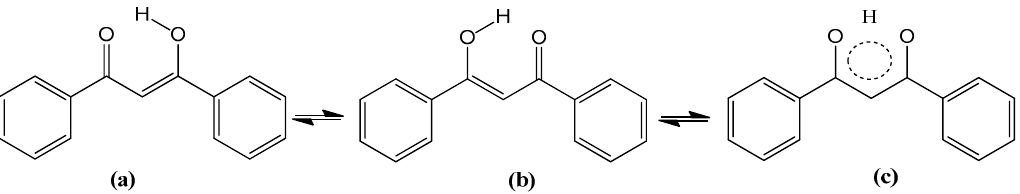
Scheme 1. Tautomeric equilibrium of dibenzoylmethane.